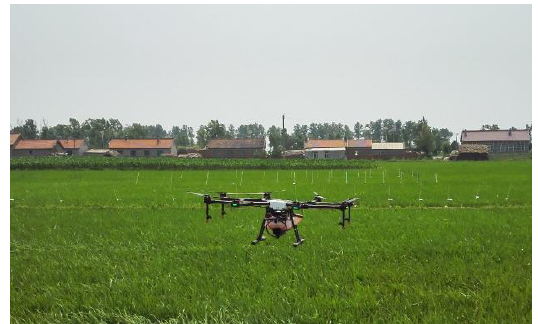
Figure 1. Plant protection unmanned aerial vehicle (UAV).